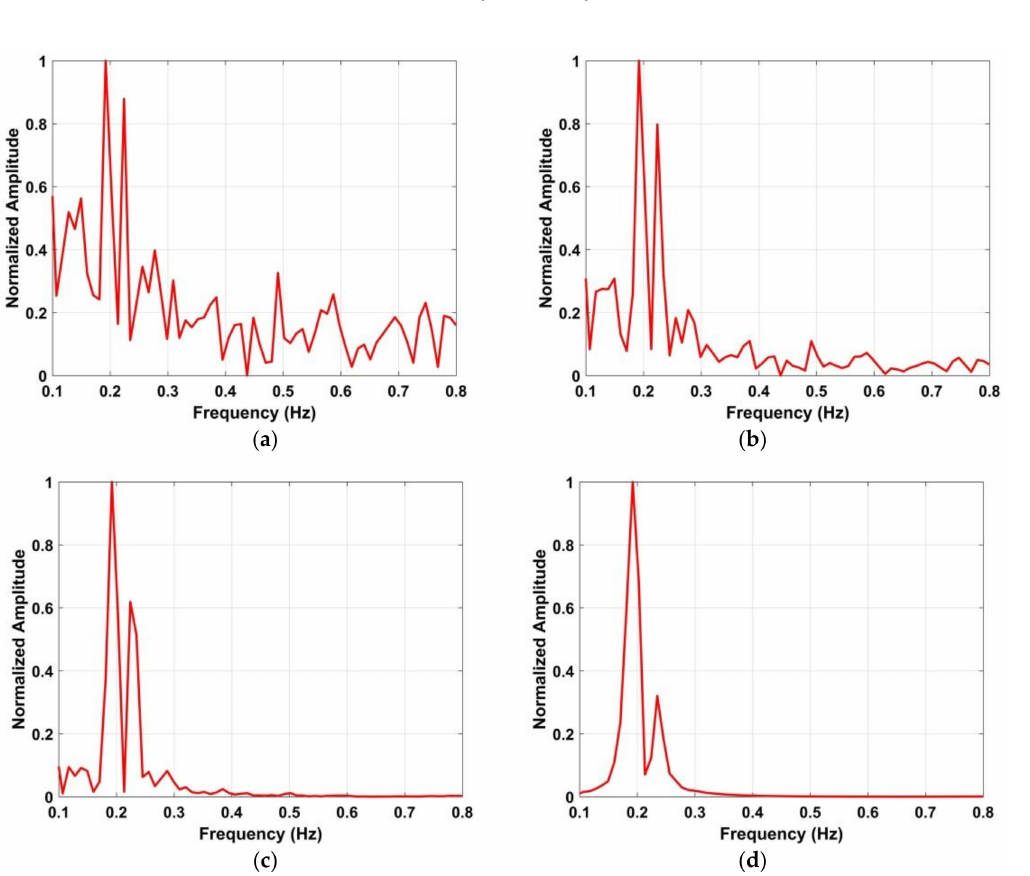
Figure 9. Results after harmonic suppression with a human subject 6 m from the antenna ( a ) FFT, ( b ) one frequency accumulator, ( c ) two frequency accumulators, and ( d ) four frequency accumulators.